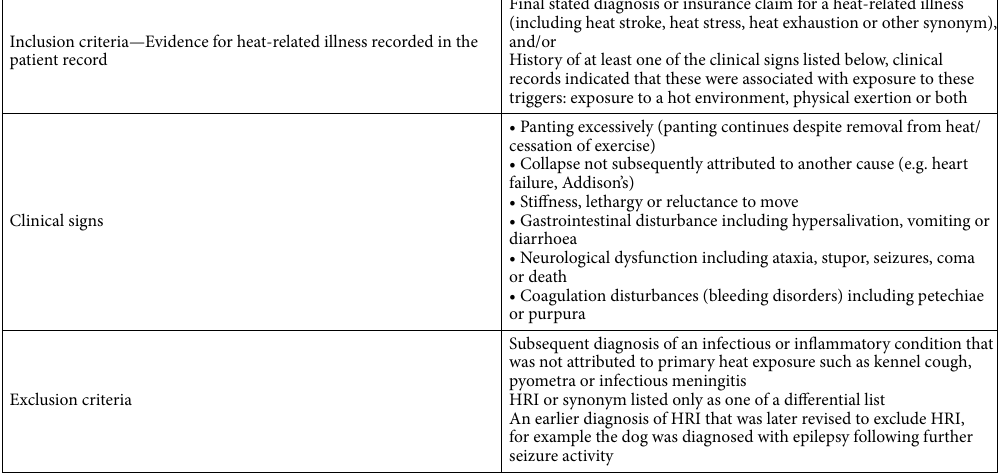
Table 1. Case inclusion and exclusion criteria used for heat-related illness (HRI) events in dogs presenting to primary-care veterinary practice, defined in Hall et al. 20 .